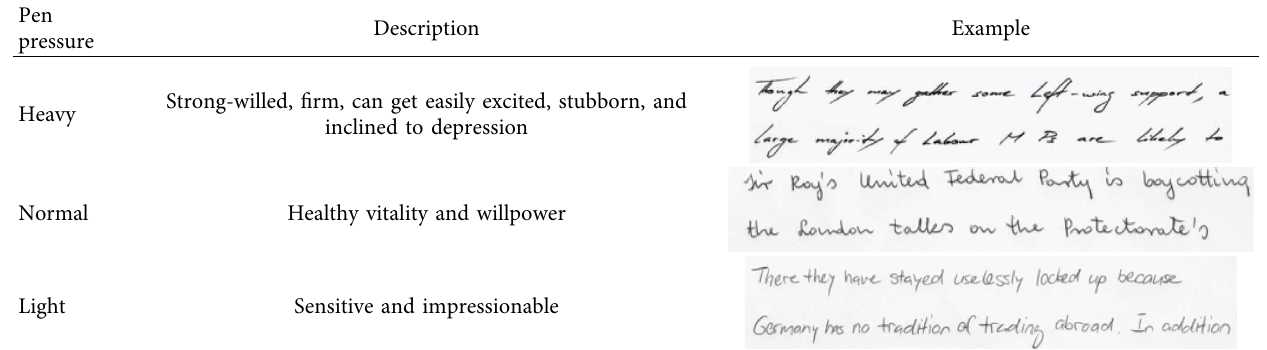
Table 7: Te pen pressure features and their corresponding